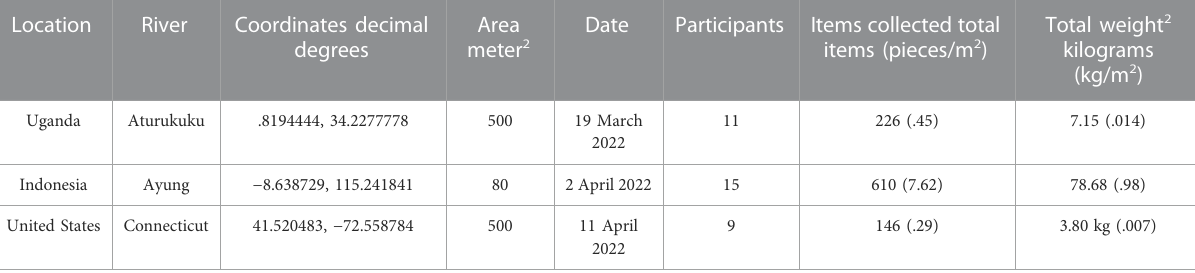
TABLE 1 Data about collection sites, with number of items collected, pieces/m 2 , total weight, and kg/m 2 .